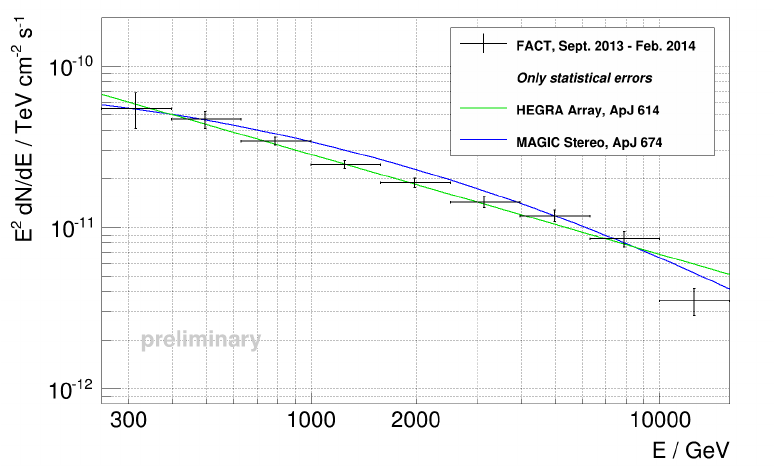
Figure 4. Unfolded energy spectrum, scaled with the square of the energy E of the Crab Nebula [3], compared to HEGRA [8] and MAGIC